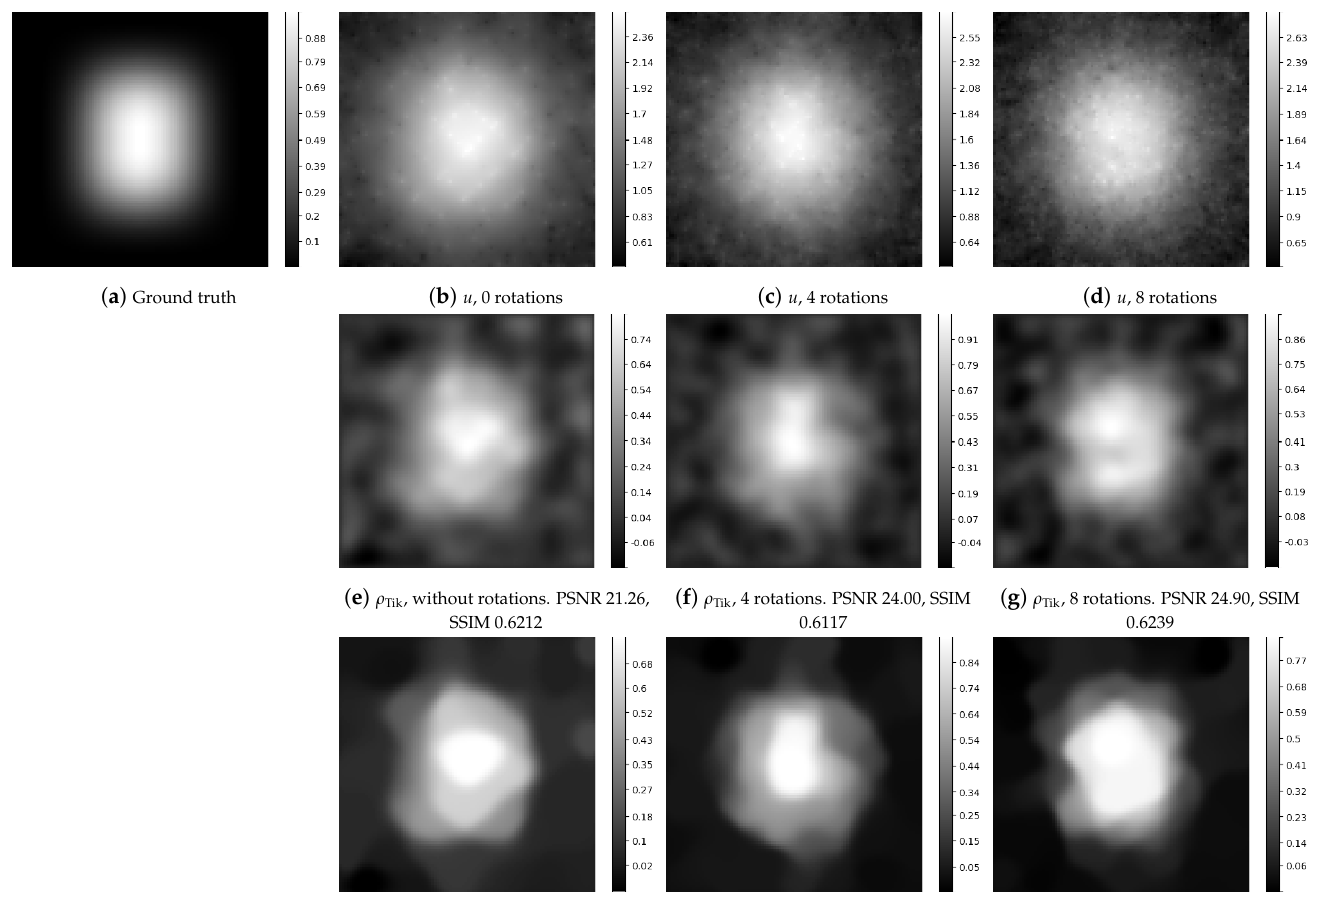
Figure 8. Reconstruction of smoothed rectangle (convolution with a Gaussian with σ of 1/10 of the image size) using model-based two-stage reconstruction for combining rotated scan trajectories. First row. Trace fields u = trace A [ ρ ] (output of Stage 1) obtained with increasing number of rotations 0,4,8. Second row. Reconstruction results ρ Tik using Tikhonov regularized deconvolution in Stage 2 with increasing number of rotations. Third row. Reconstruction results ρ TV using TV smooth regularized deconvolution in Stage 2 with increasing number of rotations. We observe qualitatively and quantitatively increasing reconstruction quality with increasing number of merged rotated scans for both Tikhonov and TV type regularization. The TV smooth regularized deconvolution results in Stage 2 exhibit the well-known staircasing